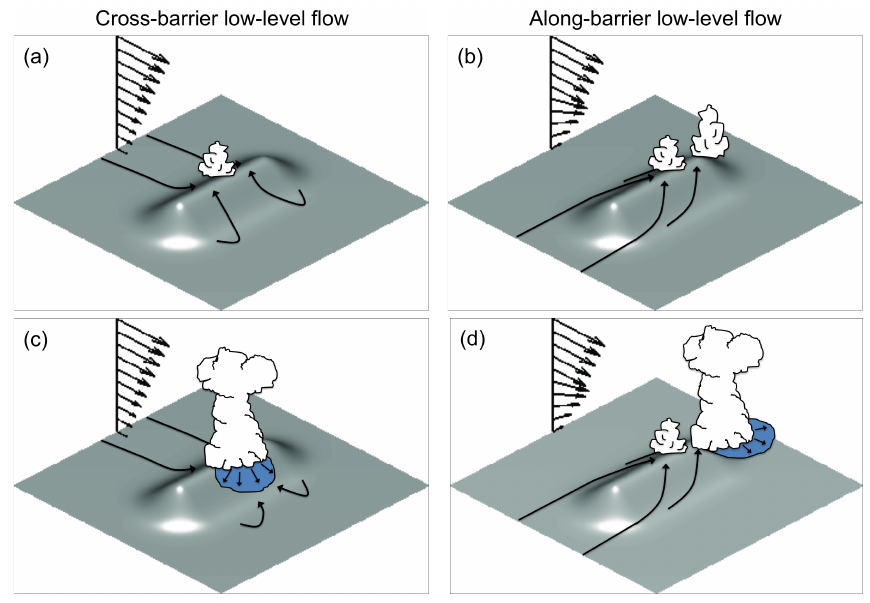
Figure 8. Schematic of the role of low-level winds on deep-convective evolution over a heated ridge, from Soderholm et al. [64]. For cross-barrier low-level winds ( a ) and ( c ), windward flow converges with reversed lee-side flow over or downwind of the crest, producing strong updrafts. Cumulonimbi thus initiated create cold pools that cut off the lee upslope flow and thus weaken the elevated convergence. For along-barrier low-level winds ( b ) and ( d ), the flow is drawn upslope as it parallels the ridge, again creating a convergence line along the crest. Cumulonimbi thus initiated create cold pools that propagate downwind and do not weaken the elevated convergence. c (cid:13) American Meteorological Society. Used with